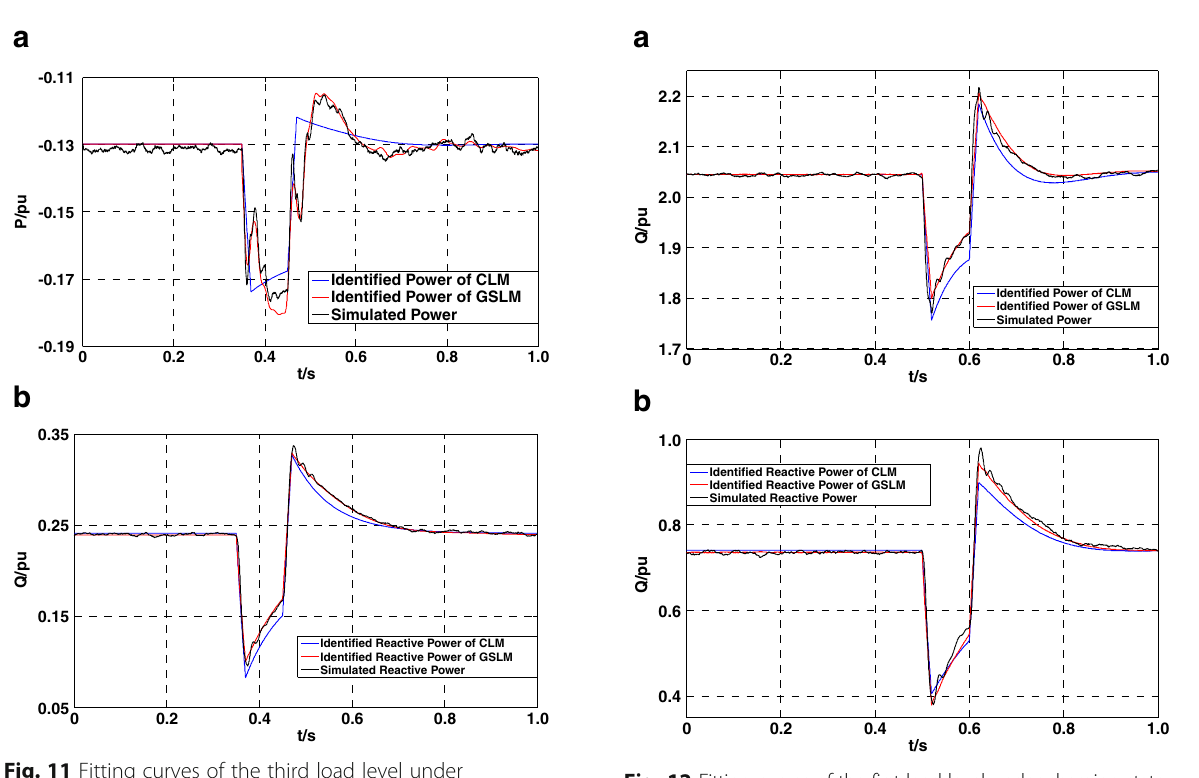
Fig. 12 Fitting curves of the first load level under charging state